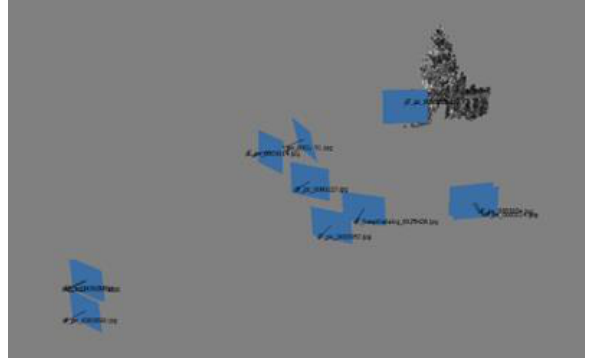
Figure 7. Camera positions for the interior point of view